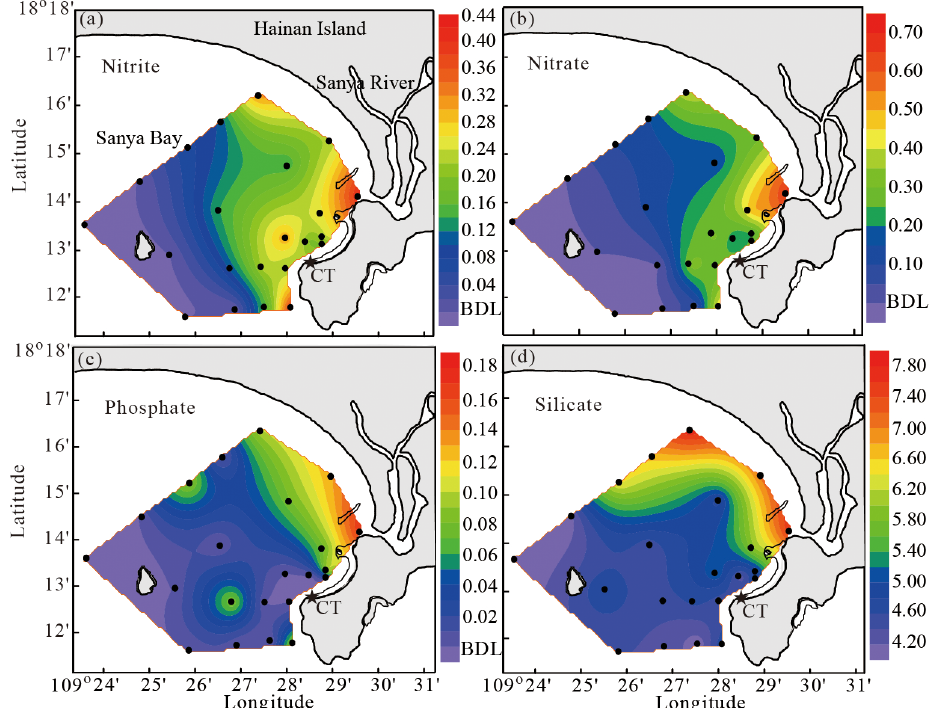
Figure 6. Surface distributions of nutrients in Sanya Bay in February 2012. (a) Nitrite, (b) nitrate, (c) phosphate, and (d) silicate. The units are in µM. BDL refers to below the detection limit, which is 0.04µM for nitrate and nitrite and 0.08µM for